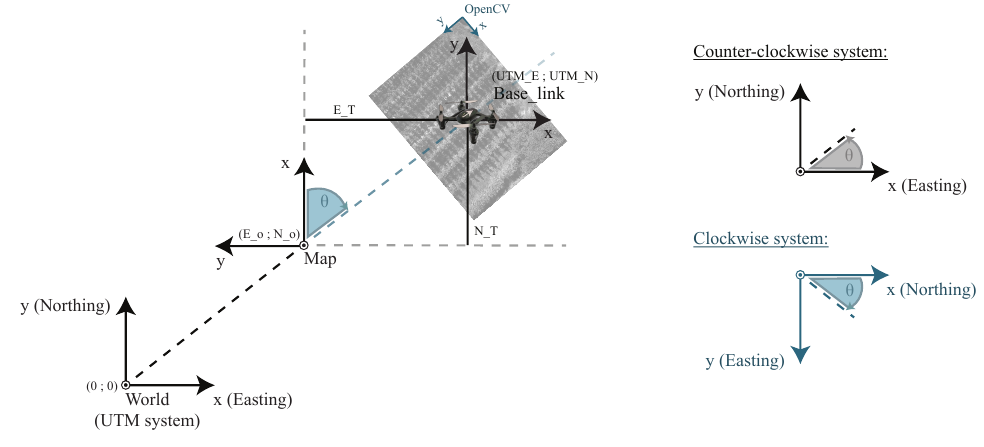
Figure 19. Interfaces’ coordinate systems: Base_link, world and map (black counter-clockwise coordinate systems), OpenCV (blue clockwise coordinate